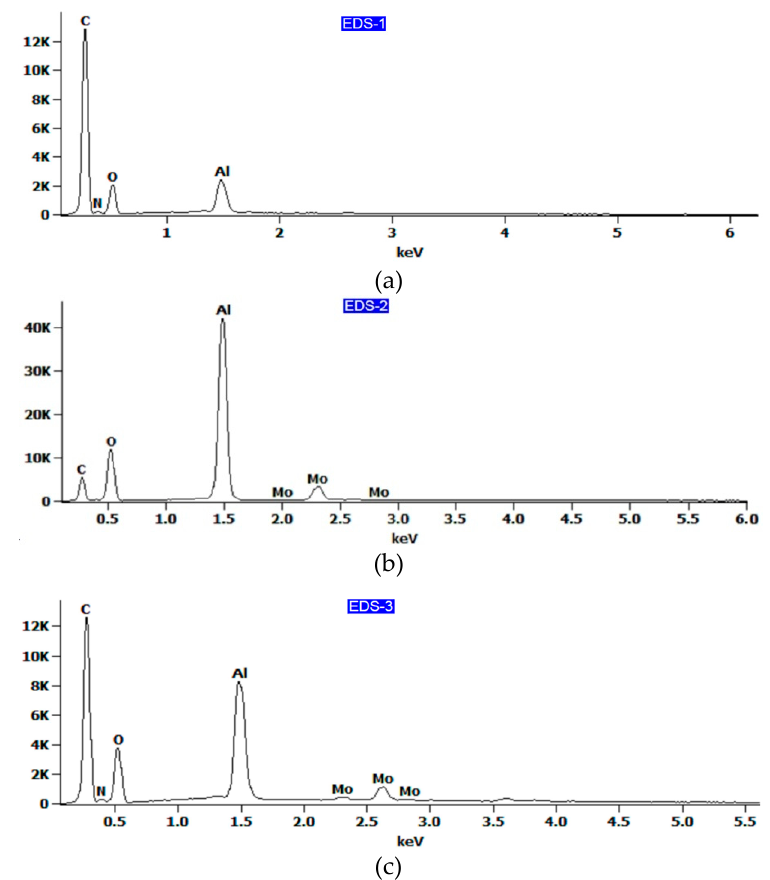
Figure 19. EDS spectra for the fractured surfaces of the ( a ) flexible adherend in a variant with adhesive